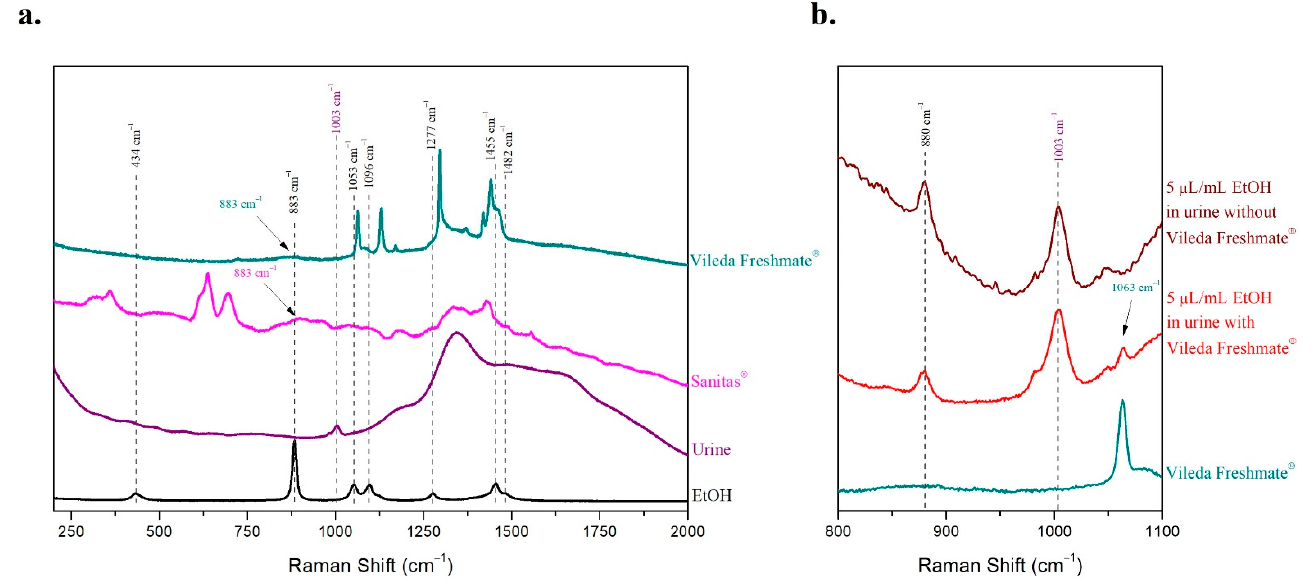
Figure 8. ( a ) The Raman spectra of ethanol, human urine, and the two transparent cling films (Sanitas ® and Vileda Freshmate ® ) were recorded, and the characteristic peaks of ethanol and urine are noted with dashed lines; ( b ) the Raman spectrum of the 5 µ L/mL ethanol in human urine sample was recorded without and with being covered with the Vileda Freshmate ® membrane.